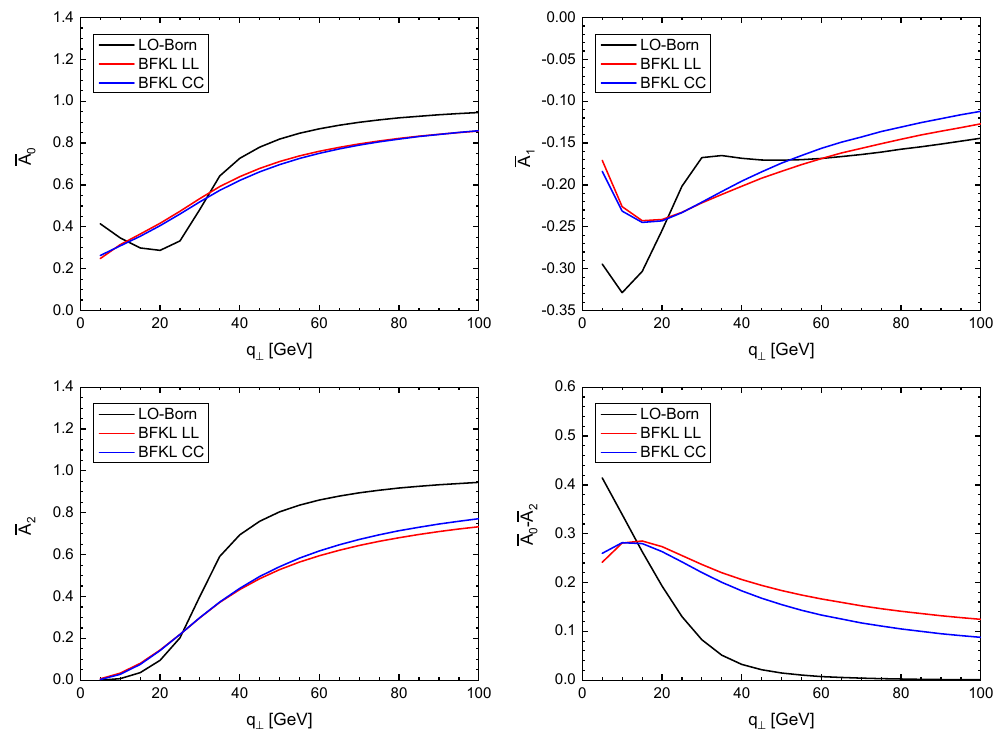
Figure 7 . The averaged over (cid:30) (cid:13)J coe(cid:14)cients (cid:22) A 0 ; (cid:22) A 1 and (cid:22) A 2 as functions of the photon transverse momentum q ? for the three indicated models together with the Lam-Tung di(cid:11)erence (cid:22) A 0 (cid:0) (cid:22) A 2 . The following parameters are used: p J ? = 30 GeV, (cid:1) Y (cid:13)J = 7 and M = 35